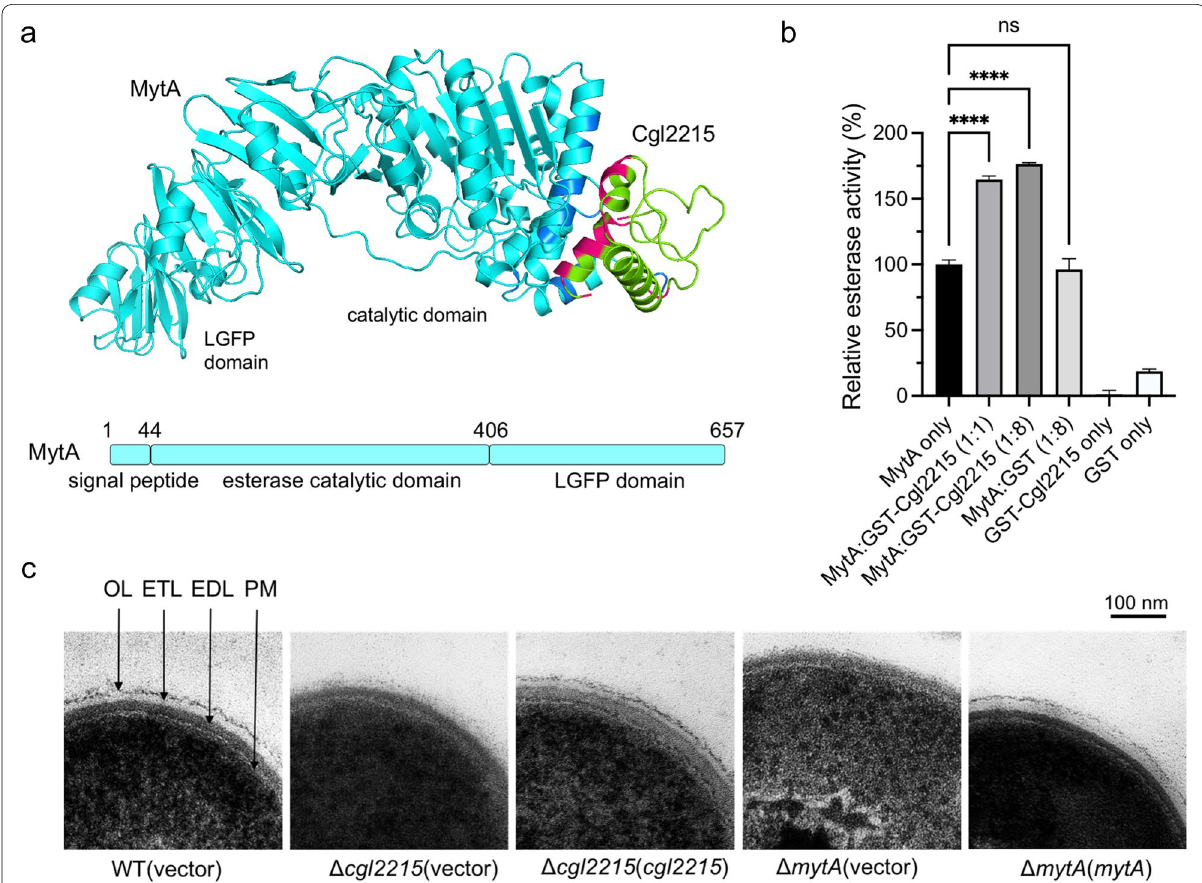
Fig. 5 Effect of Cgl2215 on the in vitro esterase activity and cell envelope of C. glutamicum . a Prediction of the MytA and Cgl2215 complex by the AlphaFold-Multimer. MytA and Cgl2215 are represented as cartoons in cyan and green, and the possible interaction regions on two chains are indicated by blue and rose. b In vitro esterase activity assay of the purified MytA proteins with the addition of the purified GST or GST-Cgl2215 proteins. The mean values and SD from at least two repeats are shown. **** P < 0.0001. c TEMs of C. glutamicum strains. PM, plasma membrane; EDL, electron-dense layer; OL, outer layer; ETL, electron-transparent